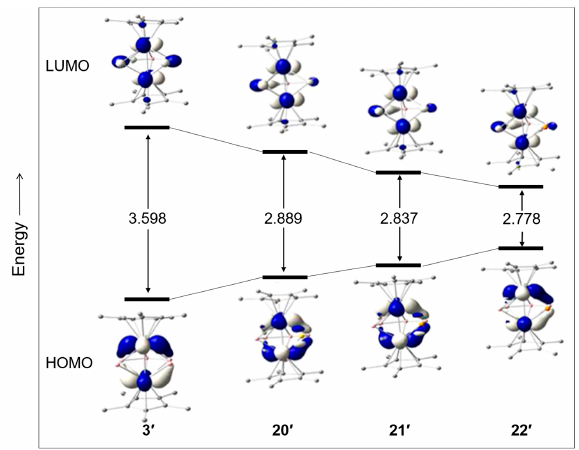
Figure 6. HOMO and LUMO plots of 3’ and 20’ – 22’ (HOMO-LUMO gaps in eV). Reprinted and adapted with permission from Ref. [78]. Copyright (2013) American Chemical Society.